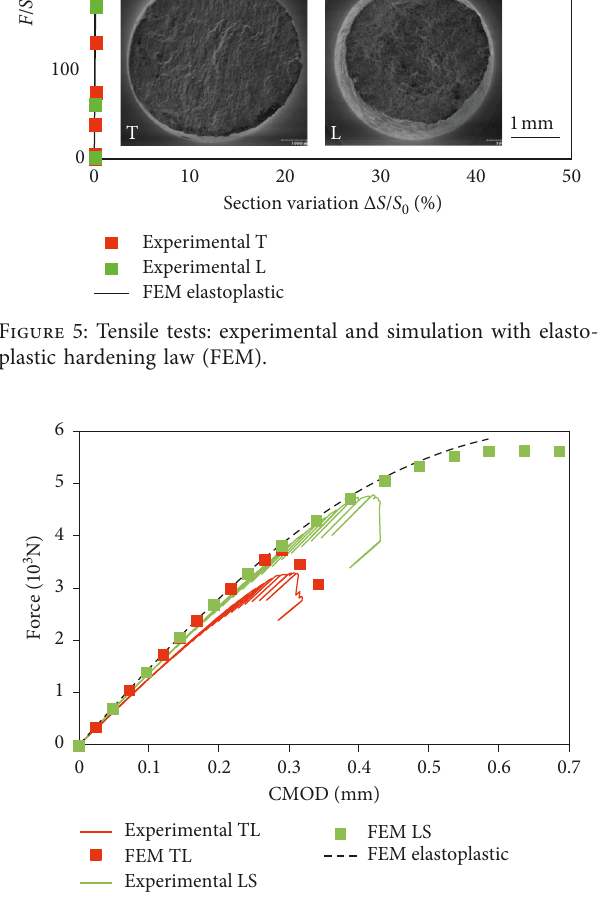
Figure 6: Experimental toughness tests and finite element simu- lations (FEMs) for configuration LS and